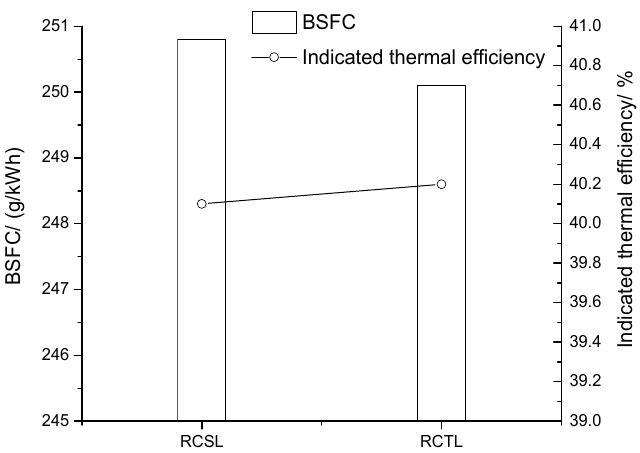
Figure 11. BSFC and indicated thermal efficiency for two combustion chambers at BMEP2.6 MPa load.